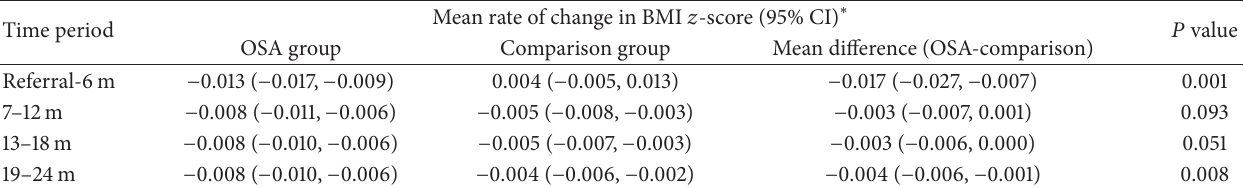
Table 2: Rate of change in BMI 𝑧 -score (units per month) after referral for OSA and comparison